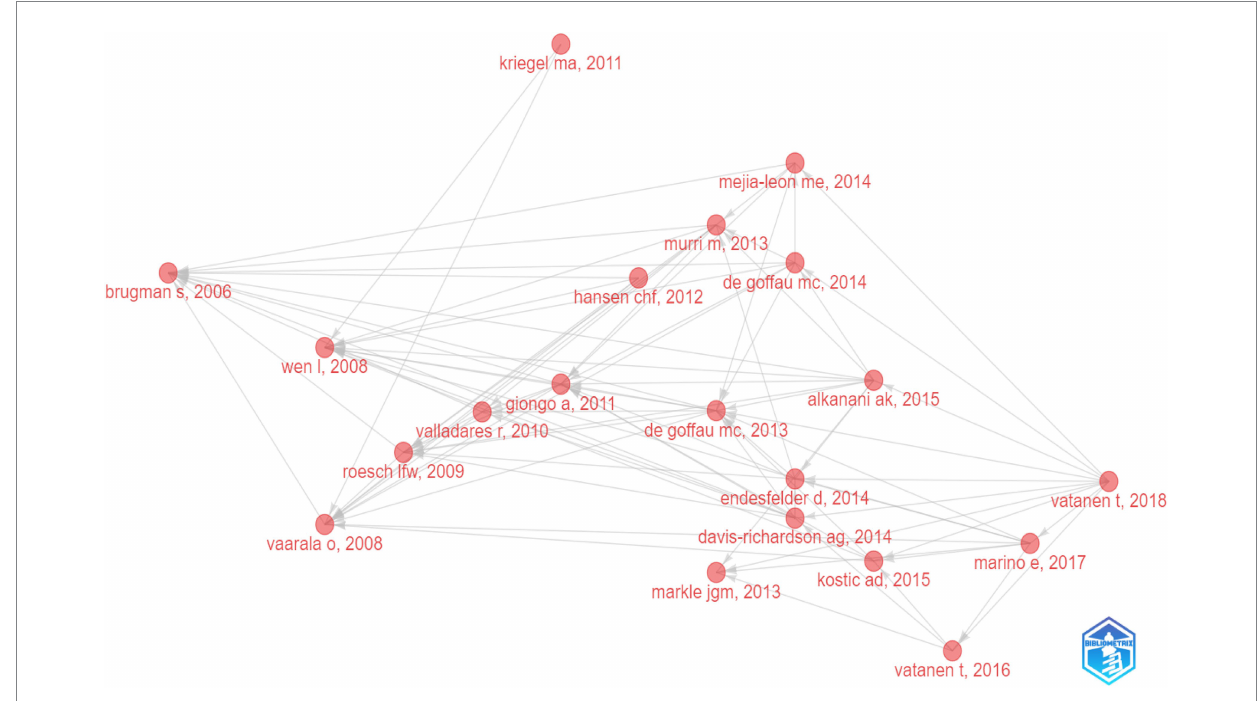
FIGURE 6 Historical direct citation network of seminal papers about gut microbiota and